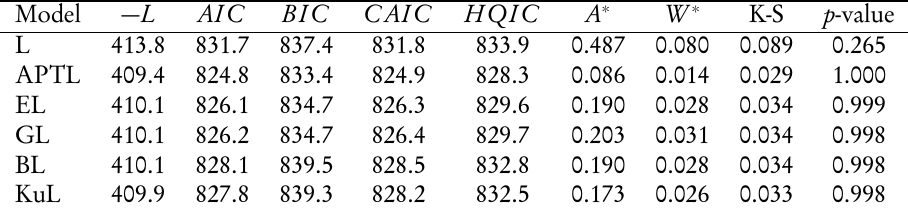
Goodness-of-fit statistics of the fitted distributions for data set 1.